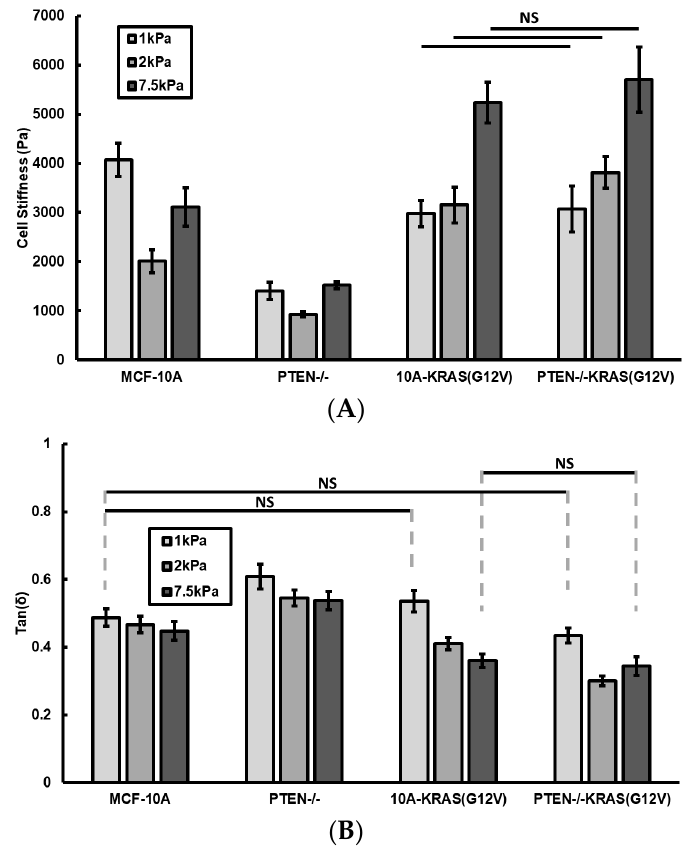
Figure 4. ( A ) Cell stiffness and ( B ) loss tangent (tan( δ )) values for control MCF-10A, PTEN − / − , 10A-KRAS(G12V), and PTEN − / − KRAS(G12V) cell conditions seeded on 1, 2, and 7.5 kPa collagen-coated polyacrylamide gels. Number of cells measured: n = 17–54. NS signifies non-significant differences between two groups ( p > 0.05).